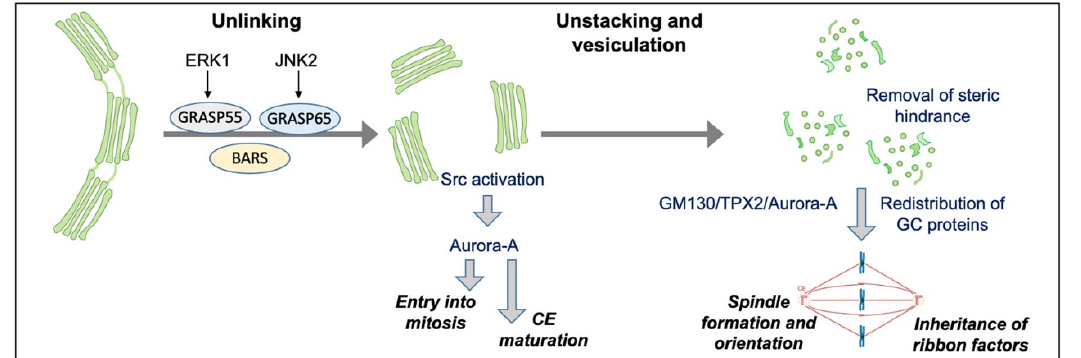
Figure 3. Schematic representation of GC mitotic partitioning and its functional connections with the regulation of mitosis. During the cell cycle, the GC undergoes sequential and reversible disas- sembly steps. During G2, the Golgi complex is unlinked process thanks to the action of BARS and the phosphorylation of GRASP65 by JNK2 and GRASP55 by ERK1. The G2-specific unlinking is required to activate a Src/Aurora-A mediated pathway to induce centrosome maturation and enter mitosis. After mitosis onset, the Golgi stacks are further disassembled into dispersed vesicles and clusters. Stack disassembly removes a steric hindrance that could hamper spindle formation; the GM130/TPX2/Aurora-A pathway is activated to aid in spindle formation and orientation. In addi- tion, a set of Golgi-structural proteins relocates to the spindle and is repurposed for its proper for- mation. In turn, the spindle mediates the inheritance of ribbon factors for GC reformation at mitotic exit.